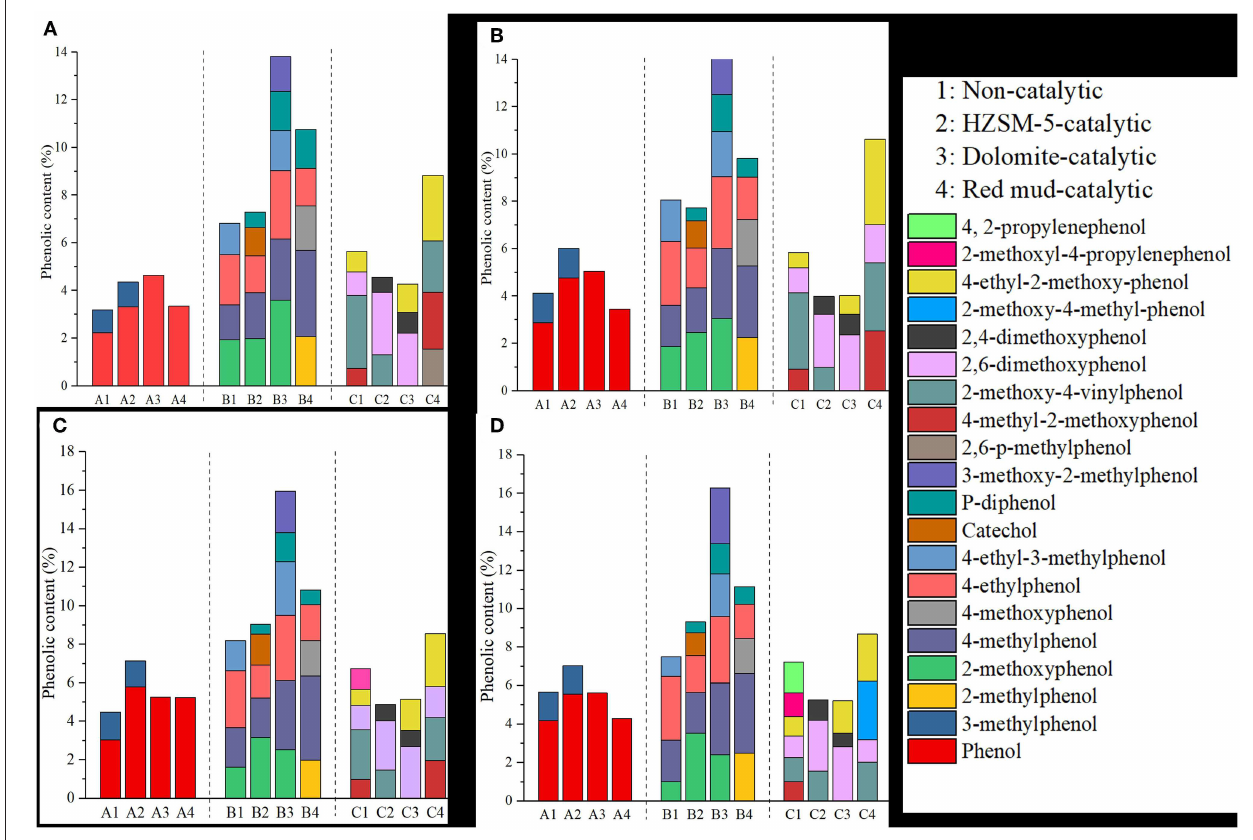
FIGURE 3 | The content of active phenols in bio-oil. (A) 450 o C, (B) 500 o C, (C) 550 o C; (D) 600 o C.